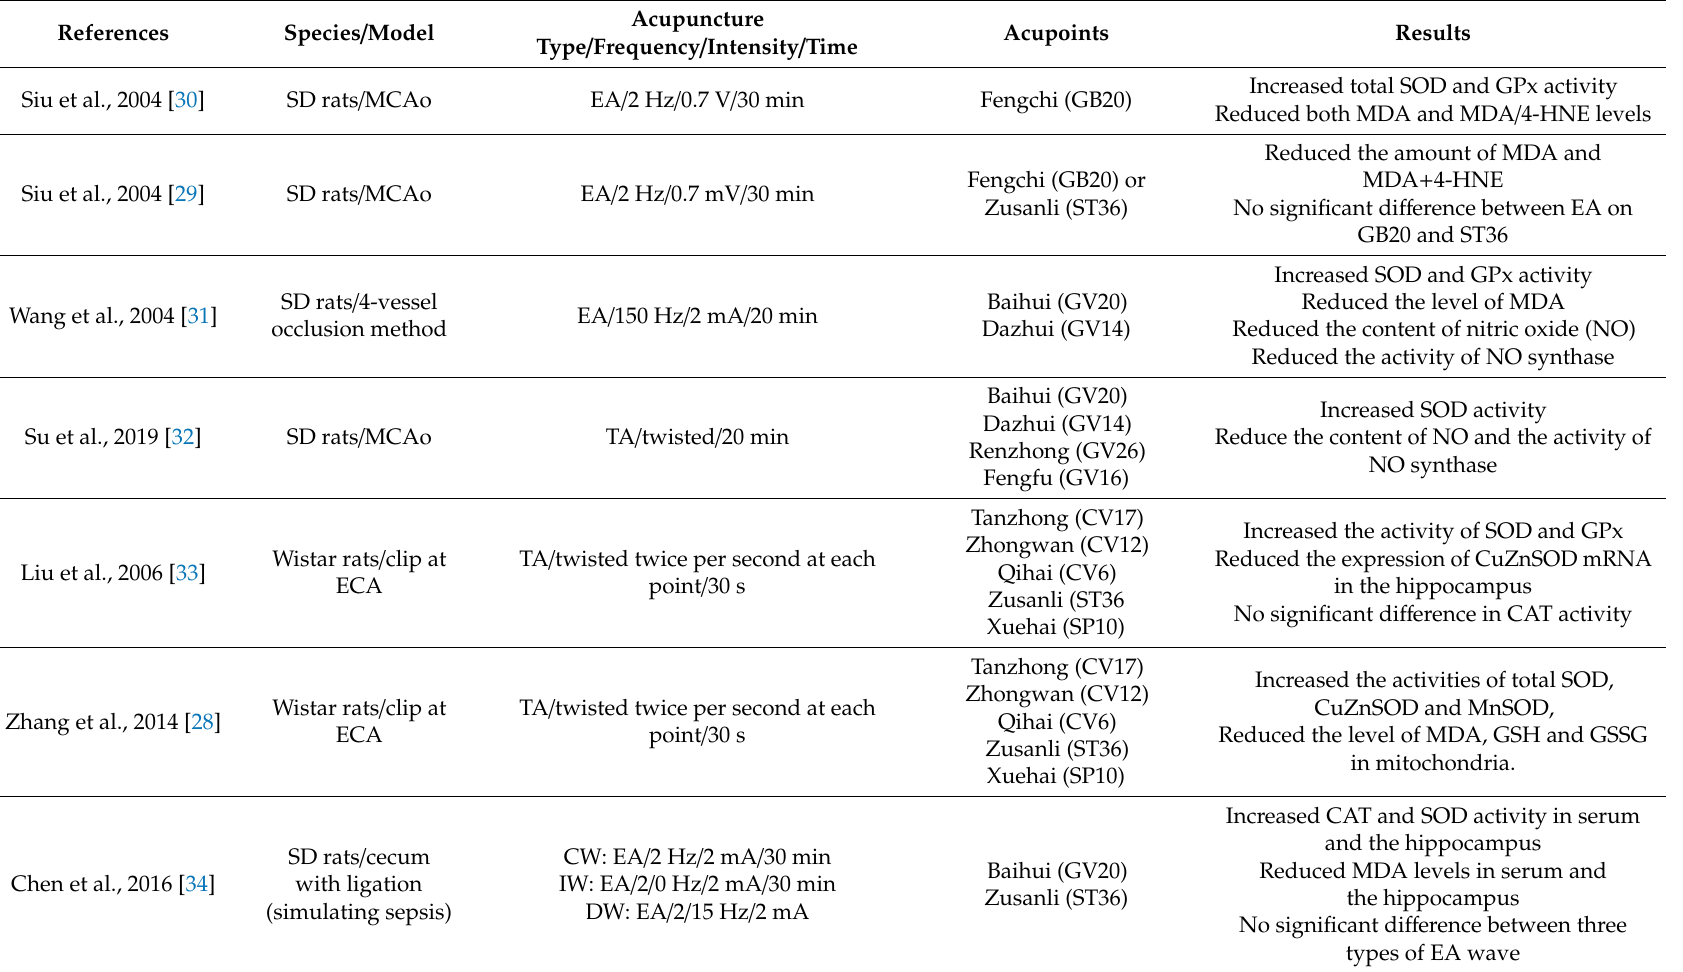
Table 1. Acupuncture eliminates ROS with antioxidant enzymes or other signaling